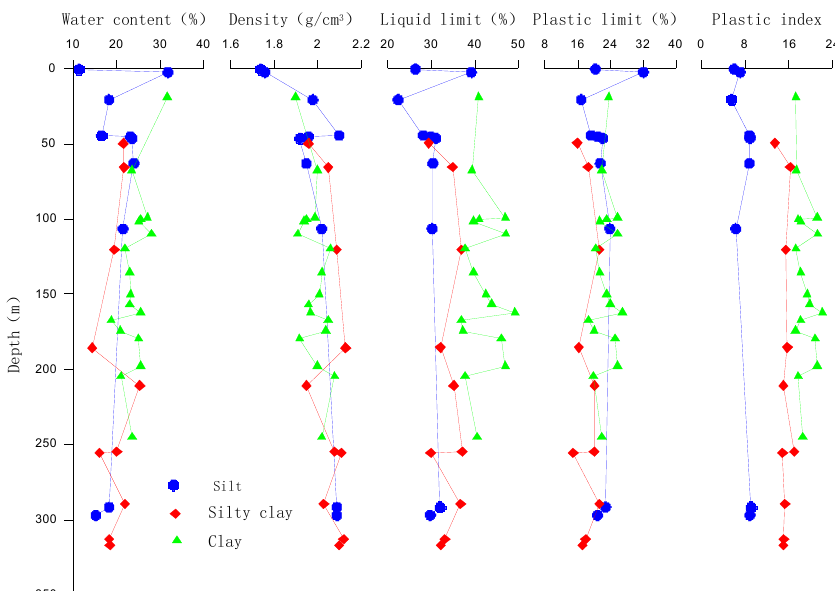
Figure 4. Diagram of soil’s basic physical and mechanical parameters by burial depth.